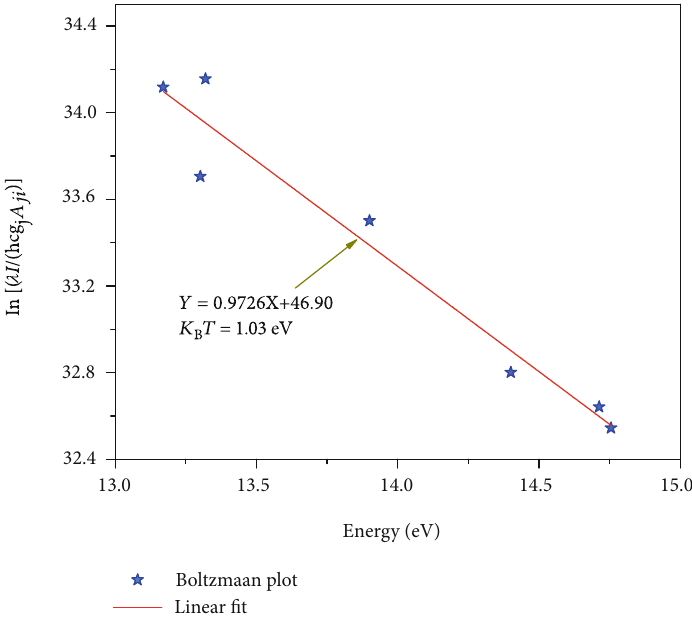
Figure 4: The Boltzmann plot method for the determination of electron